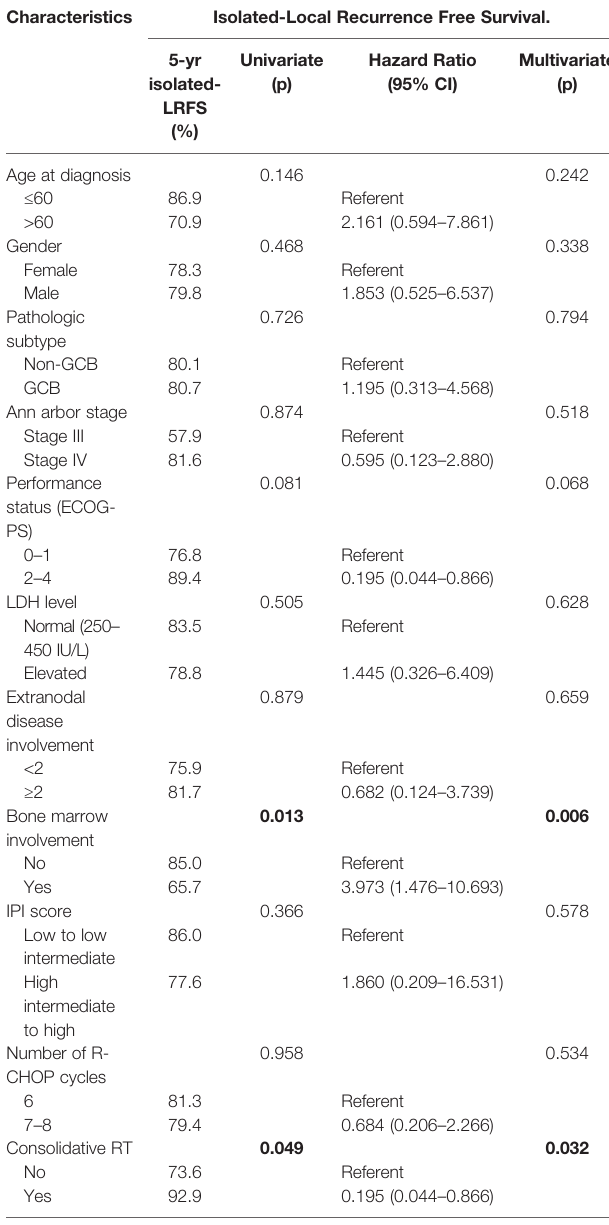
TABLE 5 | Univariate and Multivariate Analysis for Isolated-LRFS.